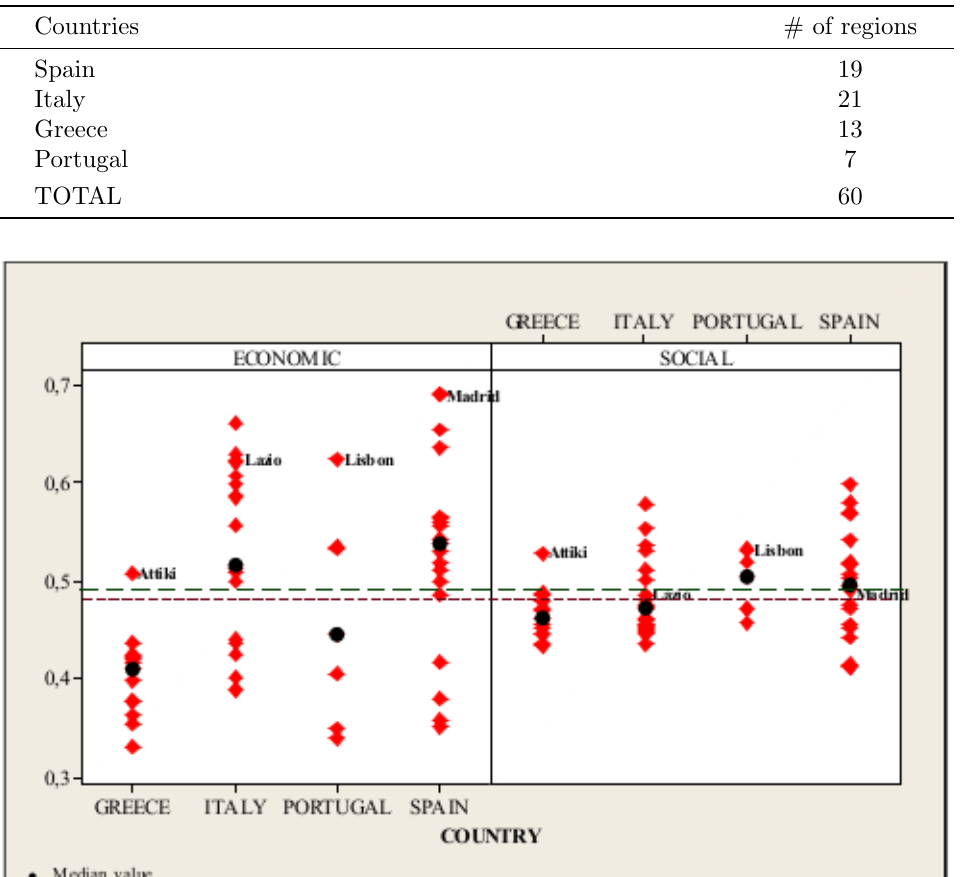
Table 4: Number of regions per country